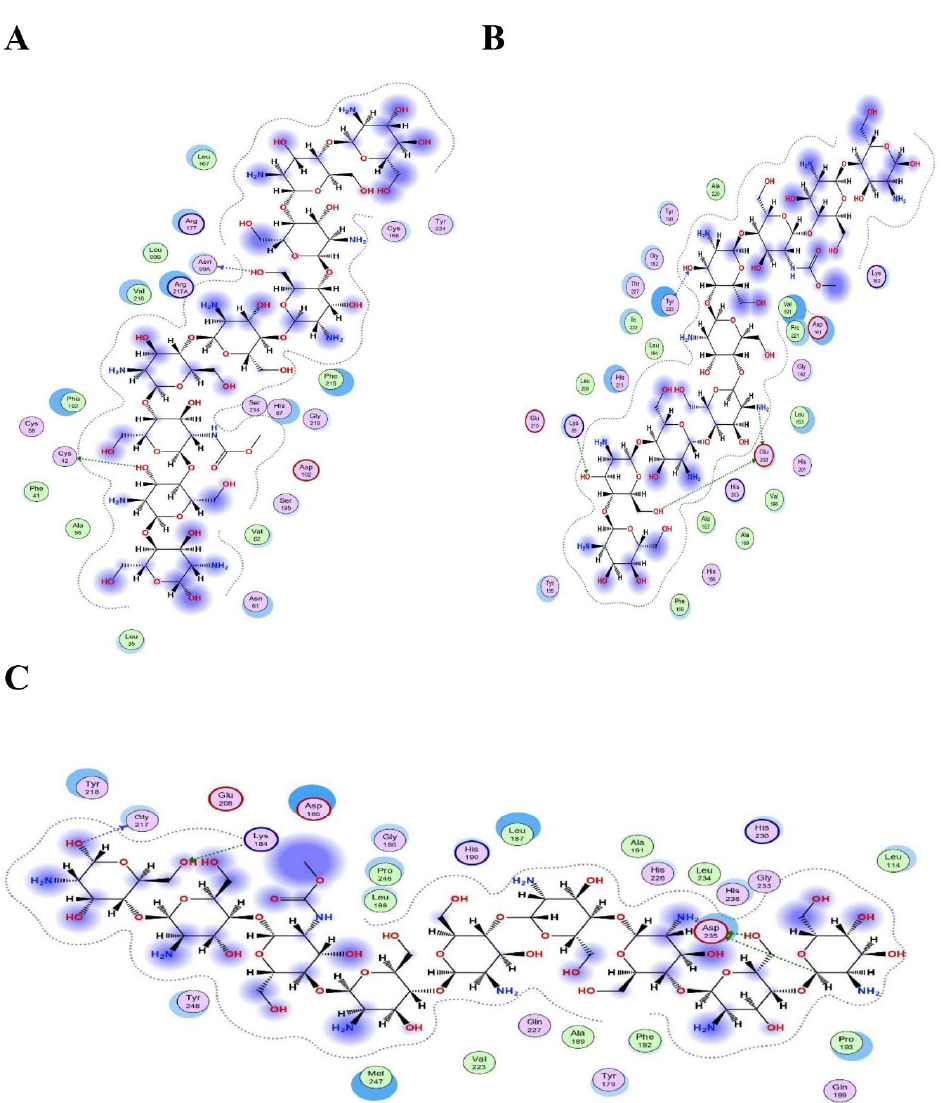
Figure 12. Schematic representation of Compound 13 “chitosan” bonded in the active site of selected three proteins (PDB ID: 1H1B ( A ), 1QIB ( B ) and 4H1Q ( C )). The active binding site shows hydrogen bonding capacity as donor atoms (purple), and acceptor atoms (green), a two-dimensional plot showing hydrogen bonding interactions and other important hydrophobic interacting residues of the target proteins.